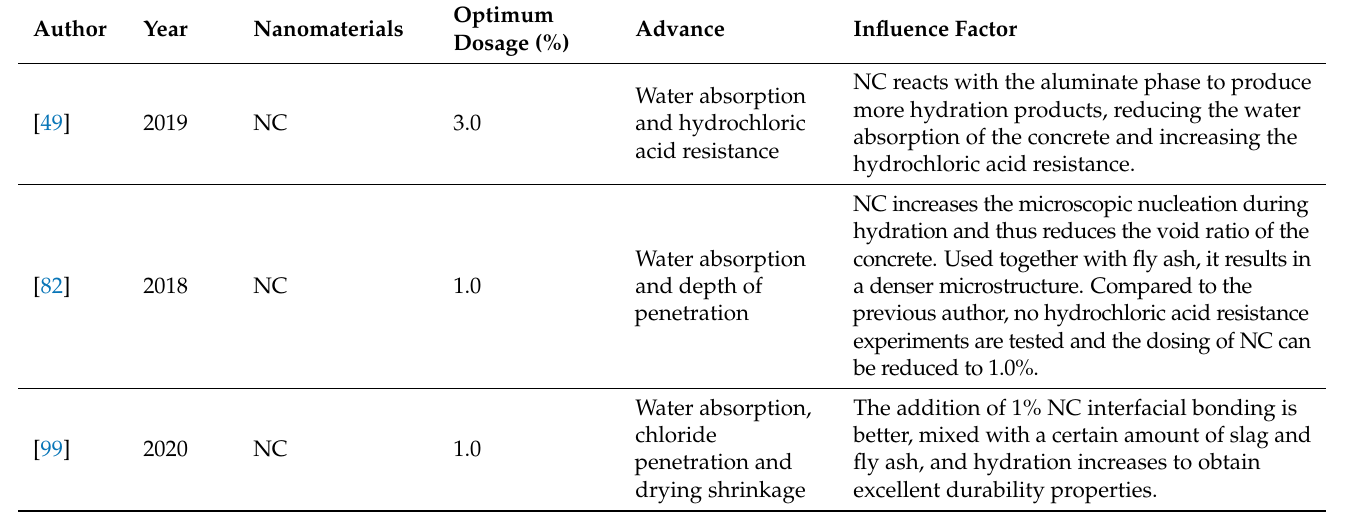
Table 2. Findings of durability of nano